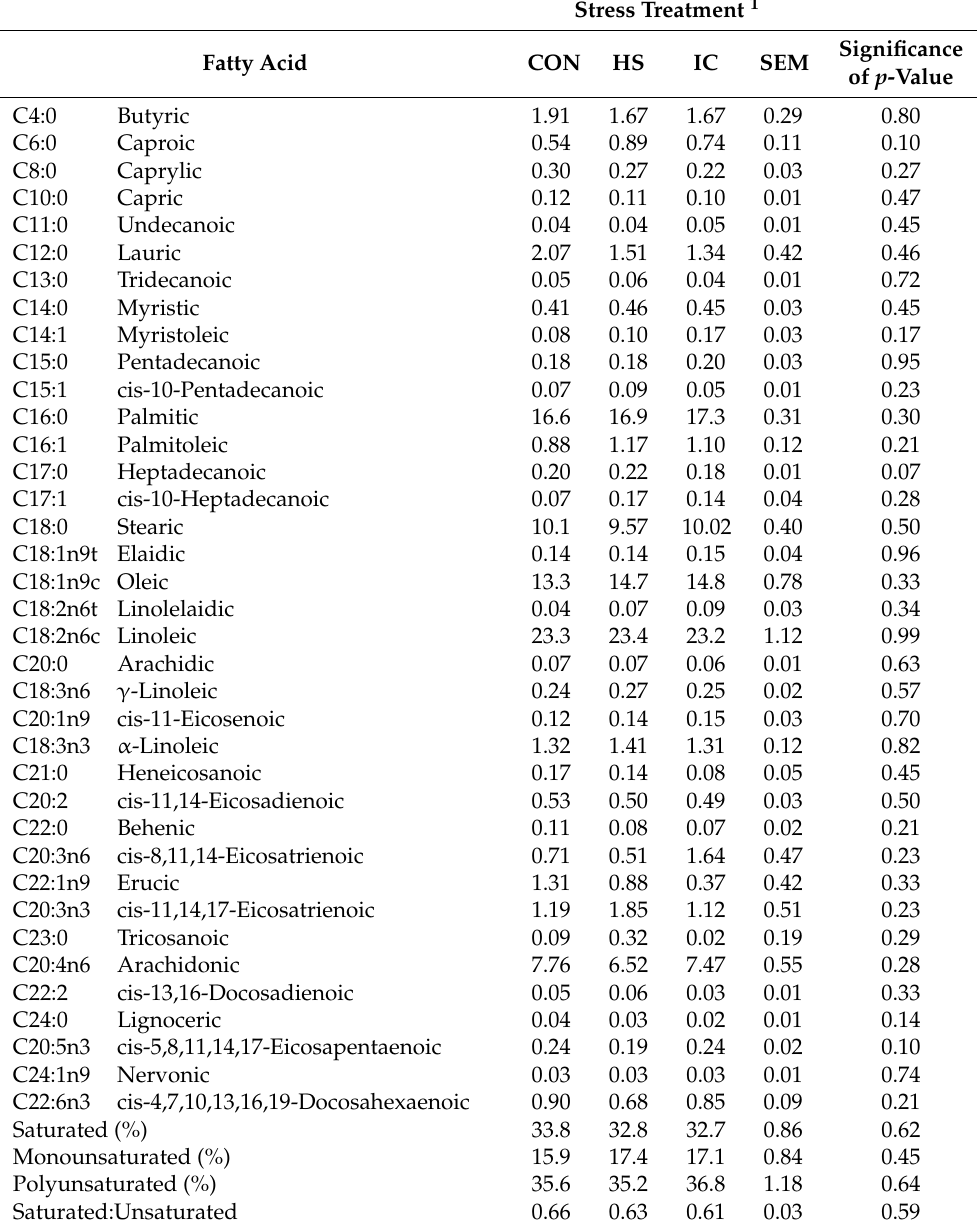
Stress Treatment